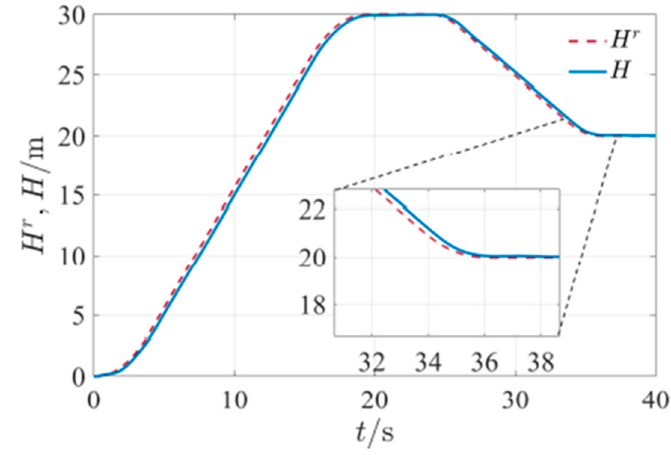
Figure 16. The evolution of corresponding height vs. time.